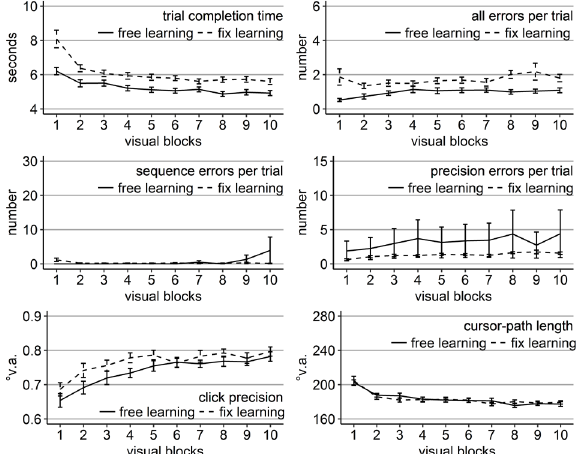
Figure 2. Performance measures during the learning phase of Experiment 1: Trial completion time in seconds, numbers of all errors, sequence errors, and precision errors per trial, click precision in °v.a., and cursor-path length in °v.a. (y-axes) over the course of the ten visual blocks (x-axes) for the two learning groups (free gaze as solid line and fix gaze as dashed line). Error bars represent standard errors of the